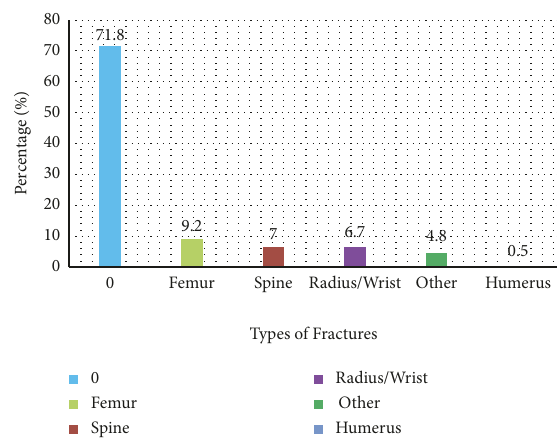
Figure 2: Percentage for types of fractures ( n � 415). Table 2: Difference in mean BMD g/cm 2 and T- score in the hip and lumbar spine (L1-4) between pretest and post-test using the paired sample t -test ( n �